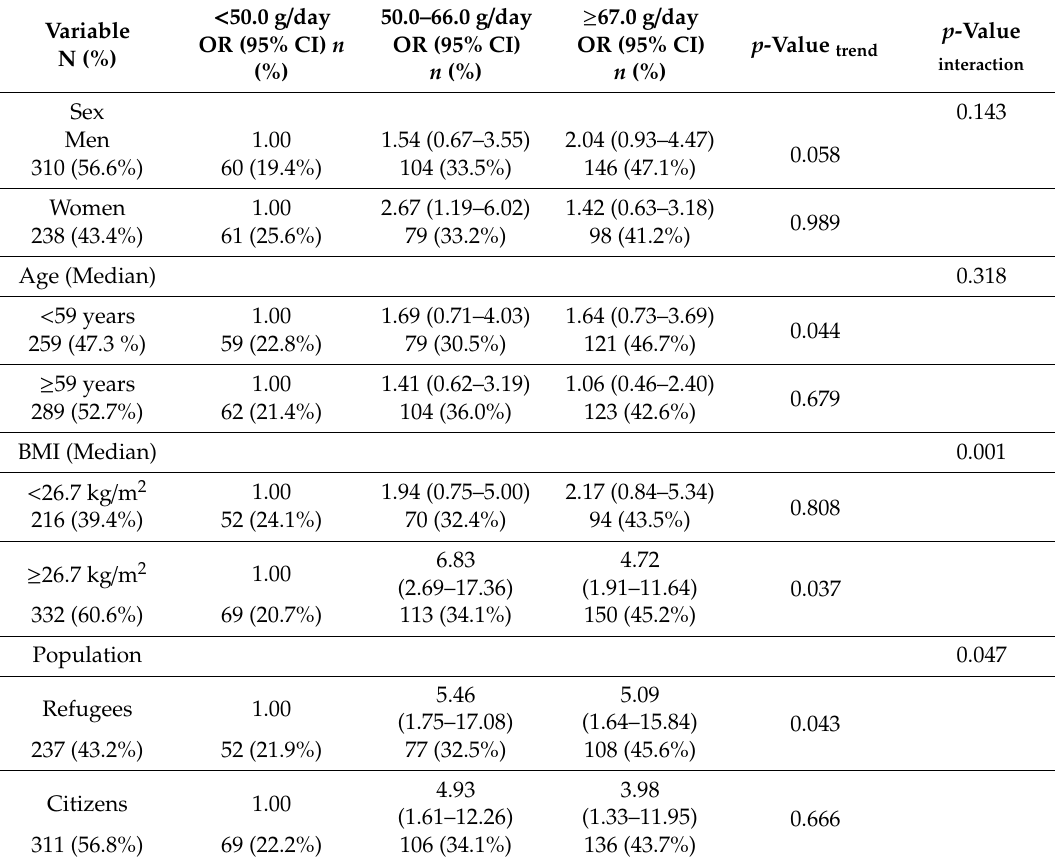
Table 3. Odds ratio (OR) (95% CI) of undiagnosed T2D by added sugar intake level and other risk factors ( n = 548).